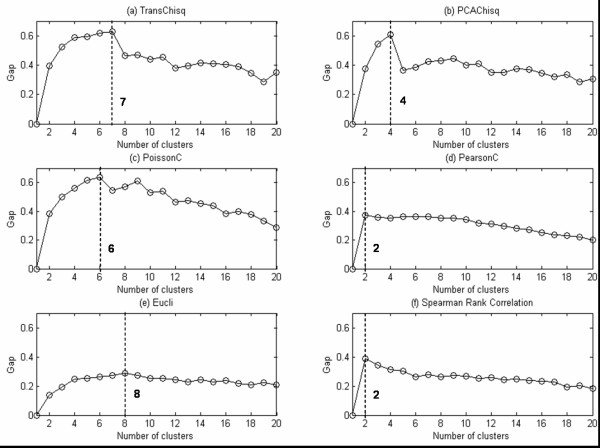
Gap statistic results on the 39 yeast sporulation genes. The x-axis represents the number of clusters and the y-axis represents the gap statistics over different number of clusters. In each sub-figure, the x-axis value associated with the largest gap statistic is the optimal selection of the number of clusters under the used similarity measure. From the shown gap curves, only TransChisq provides a correct estimate on the true number of clusters, 7.